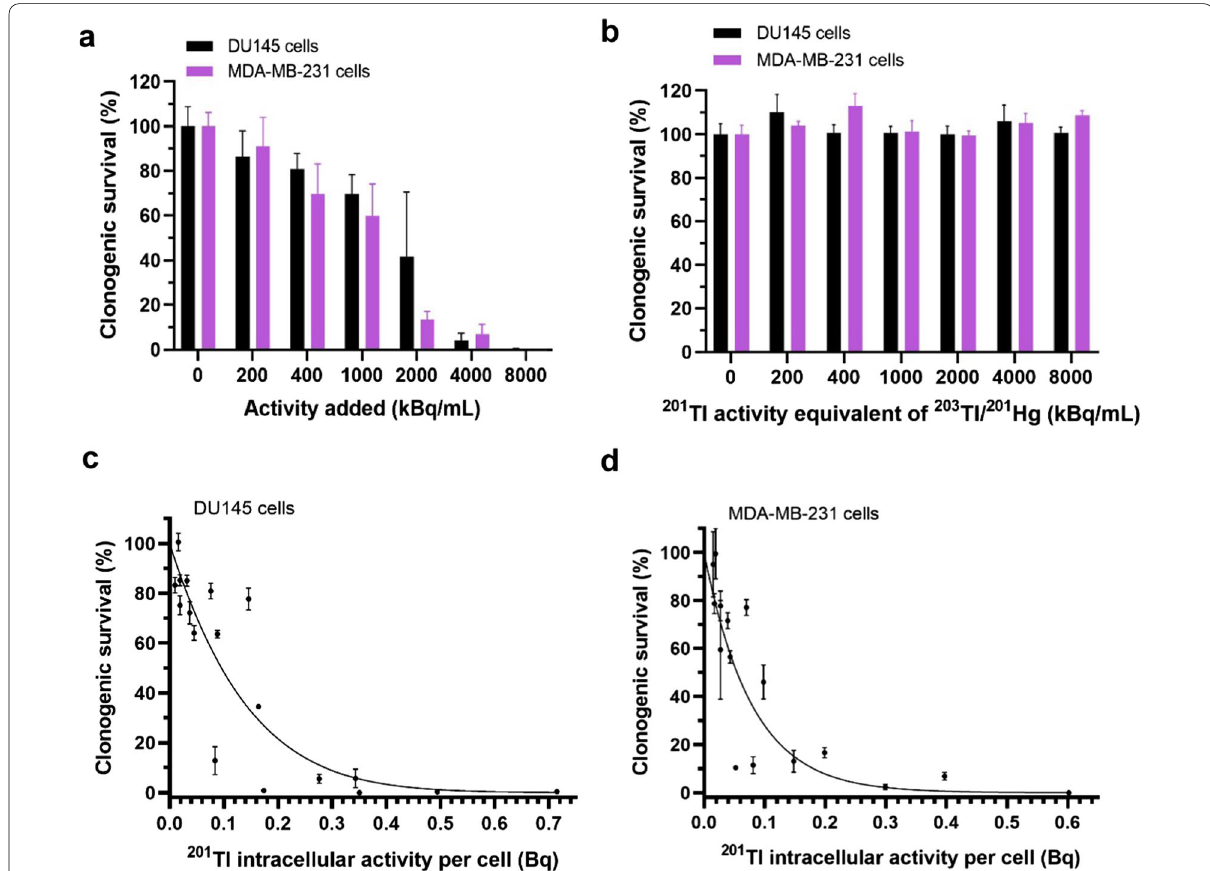
Fig. 4 201 Tl radiotoxicity—clonogenic survival. a Clonogenic survival (%) in DU145 ( n where n 1) after 90 min incubation with [ 201 Tl]TlCl in medium. b Clonogenic survival (%) measured in DU145 cells ( n = ( n 1) after 90 min incubation in medium with different concentrations of non-radioactive [ 201 Tl]TlCl decayed sample. c Clonogenic survivals (%) = versus 201 Tl intracellular activity per single cell in DU145 cells ( n calculated activity causing at least 90% reduction was 0.29 Bq for DU145 cells (95% CI 0.18–0.49) and 0.18 Bq for MDA-MB-231 (95% CI 0.10–0.39). Some error bars are smaller than the data points and not visible. Data are presented as mean